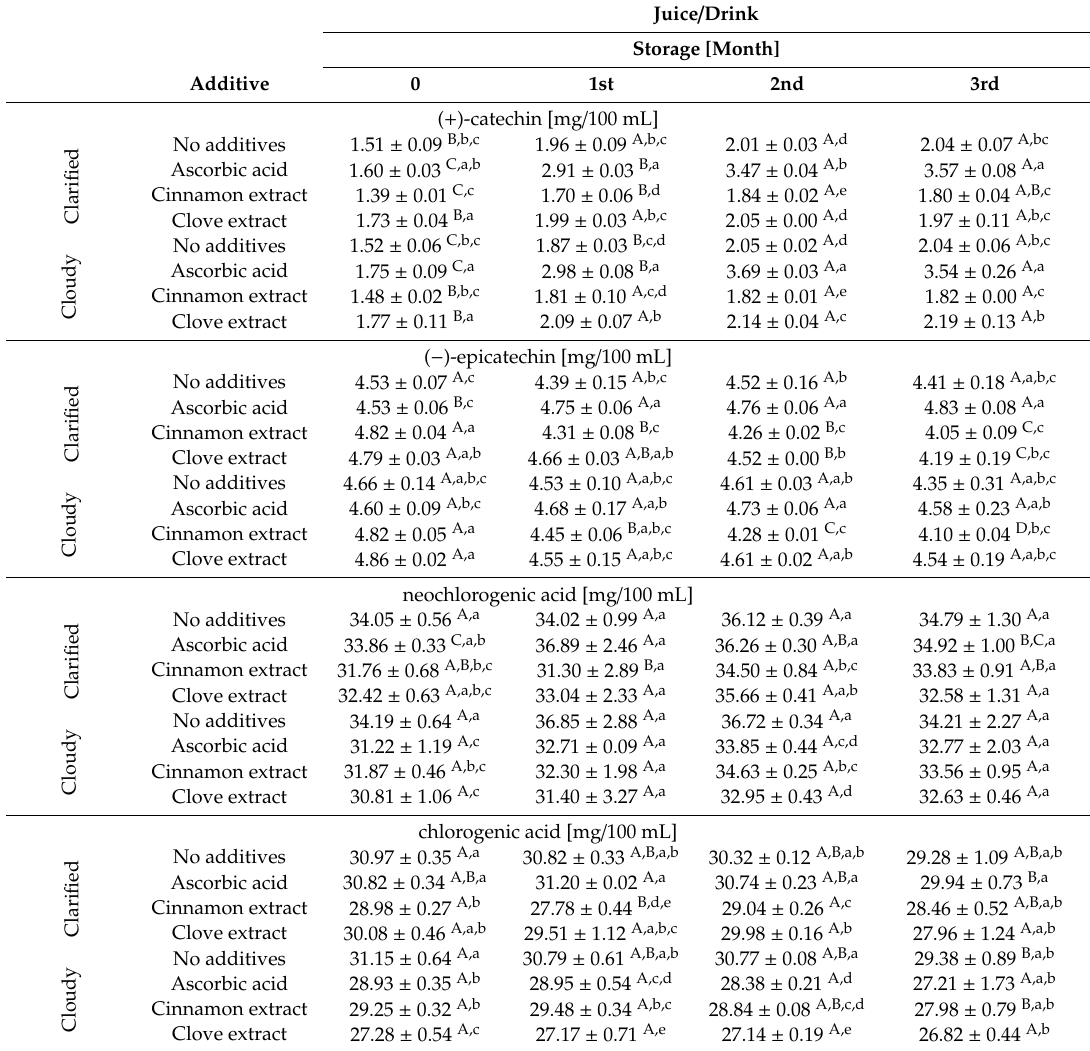
Table 4. Changes in the content of phenolic acids and flavanols during storage of tested juices /